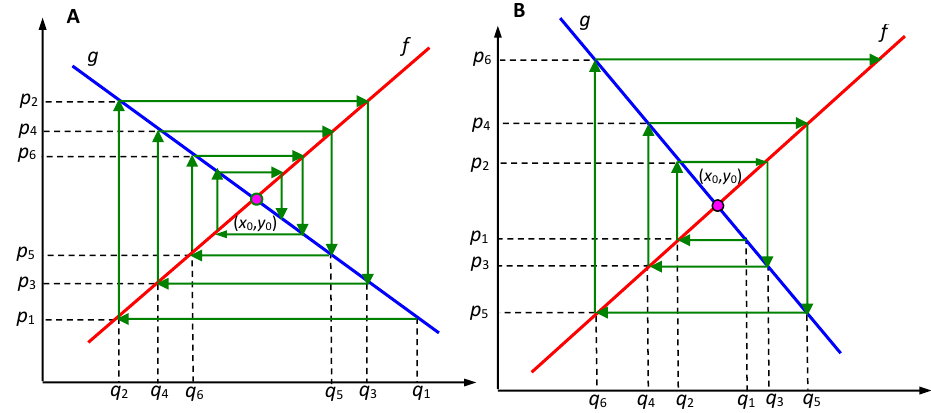
Figure 1. ( A ) stability mode, ( B ) instability mode [34].